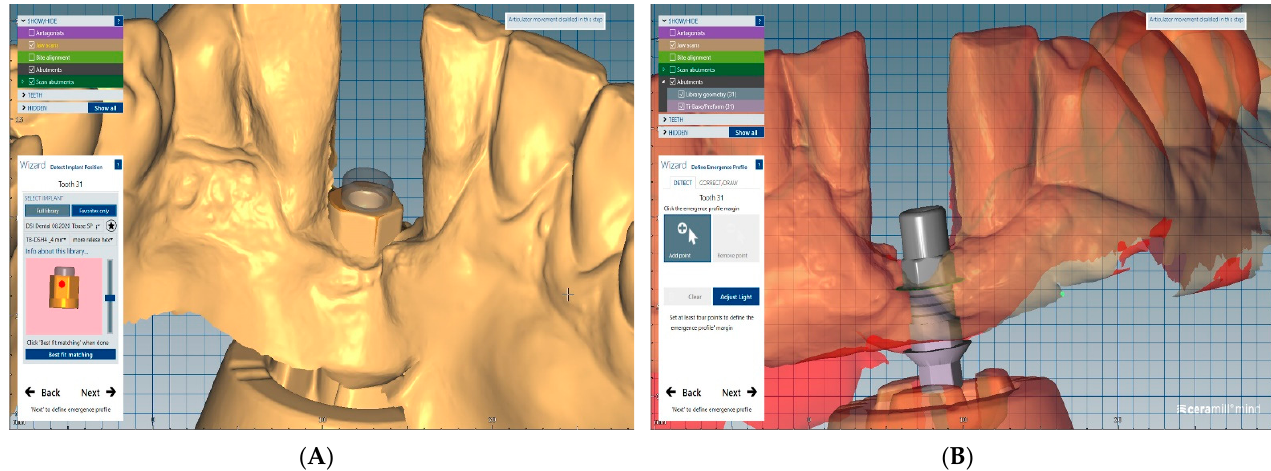
Figure 7. Ti base: ( A ) Ti base loading; ( B ) Ti base superimposed.